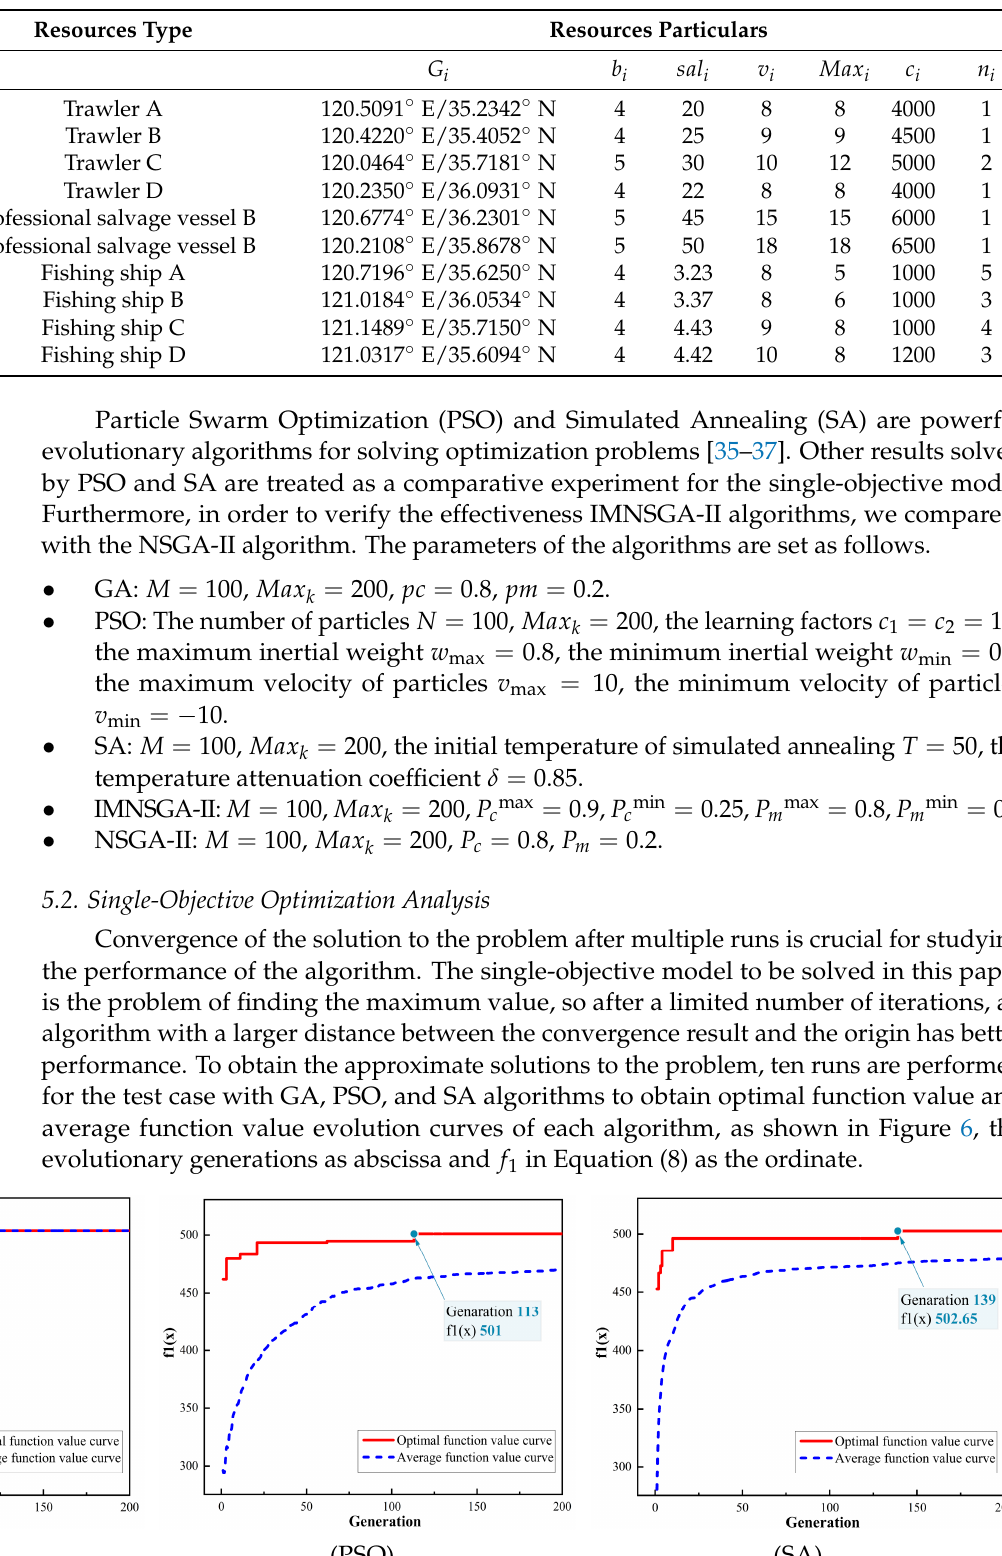
Table 3. Detailed information of available emergency disposal vessels.